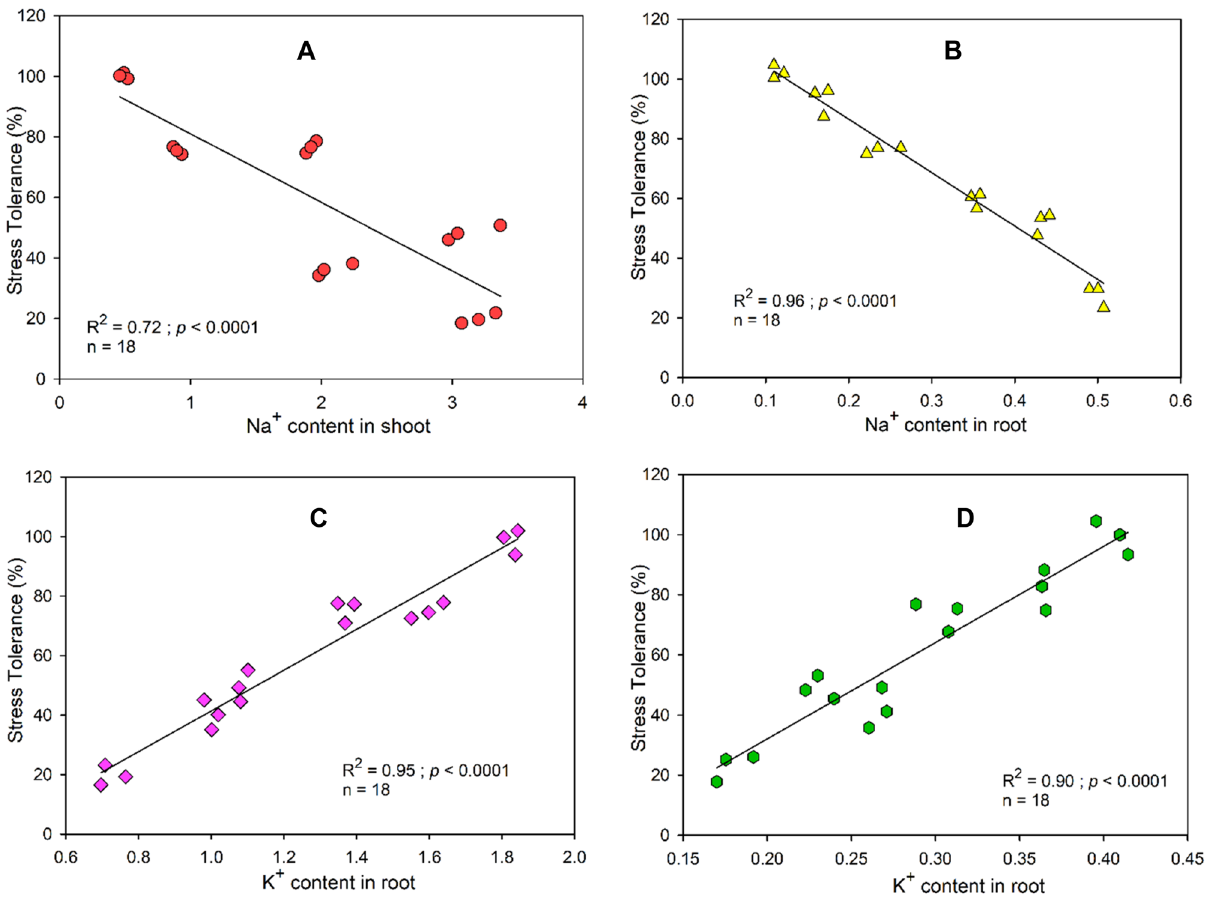
potassium (K +) content in the shoot to stress tolerance. All relationships are significant ( p ≤ 0.05, 0.001, 0.001, 0.001, and 0.01,